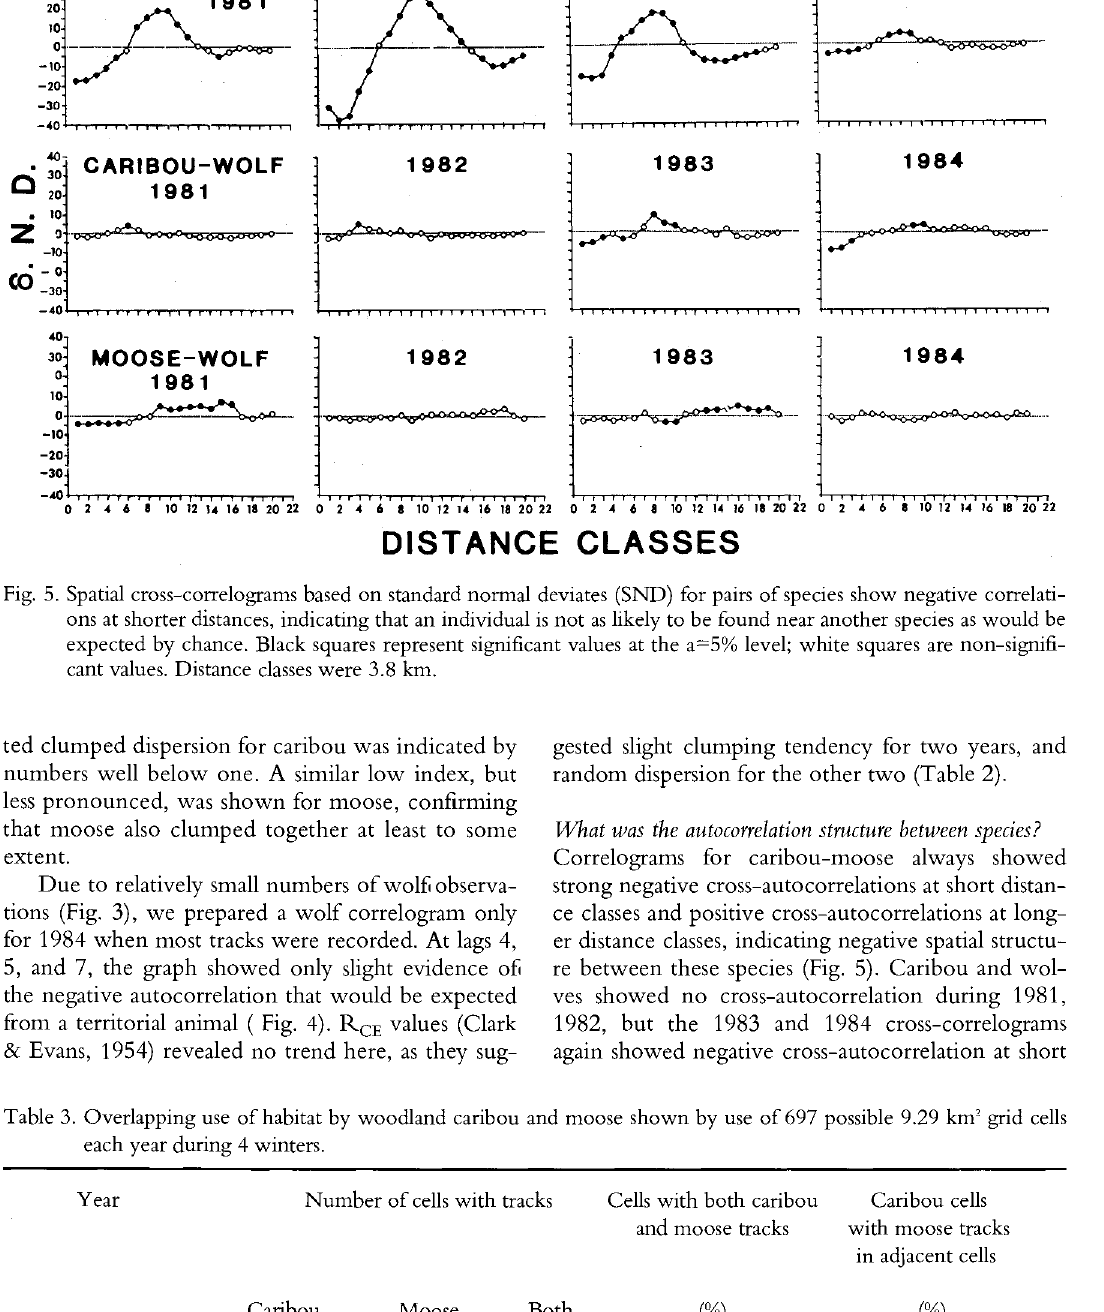
Table 3. Overlapping use of habitat by woodland caribou and moose shown by use of 697 possible 9.29 km each year during 4